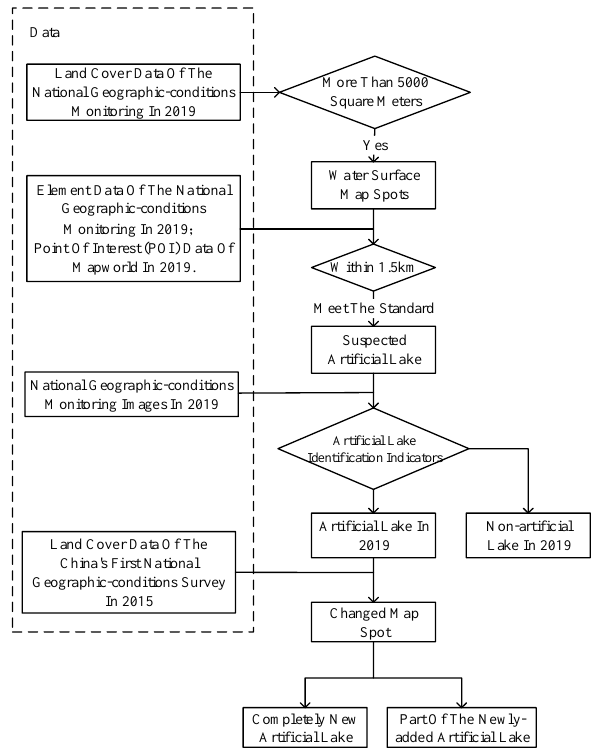
Figure 1 . Flow chart of artificial lake identification and classification